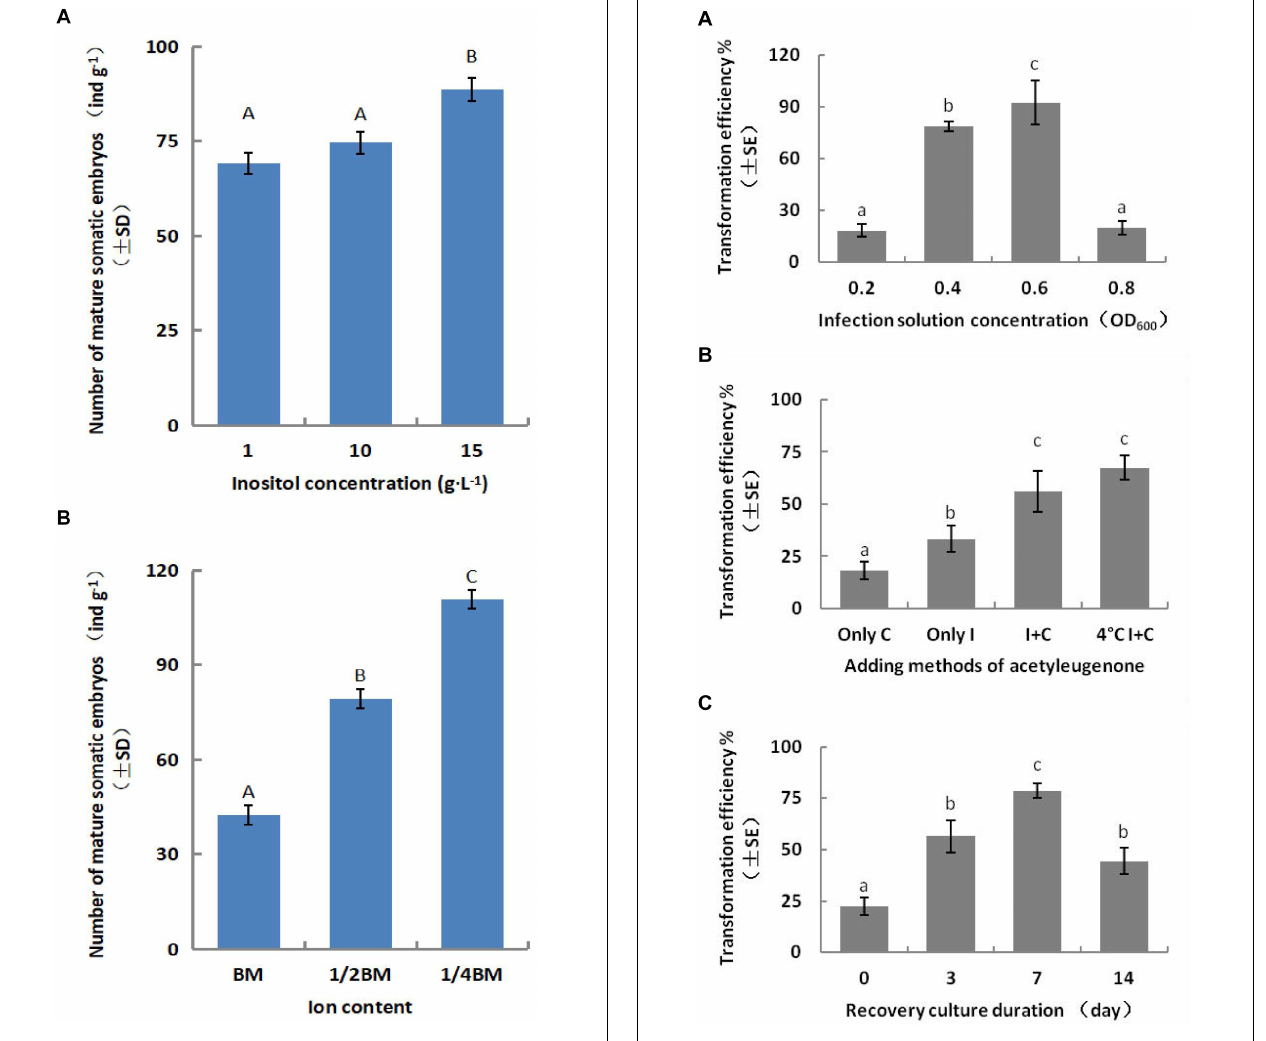
FIGURE 4 | Effect of genetic transformation conditions on transformation efficiency of L. olgensis . Effects of (A) Agrobacterium load, (B) presence of acetosyringone in different stages, and (C) duration of the recovery period after disinfection of callus with cefotaxime. Acetosyringone (100 µ M) was added in the bacterial suspension and/or co-culture medium or pre-chilled for 1 h. The resistant calluses were selected on the screening medium containing 4 mg · L − 1 hygromycin. Each value represents the mean of three independent experiments with the standard error (SE). Different letters indicate p < 0.05 (Duncan’s multiple range